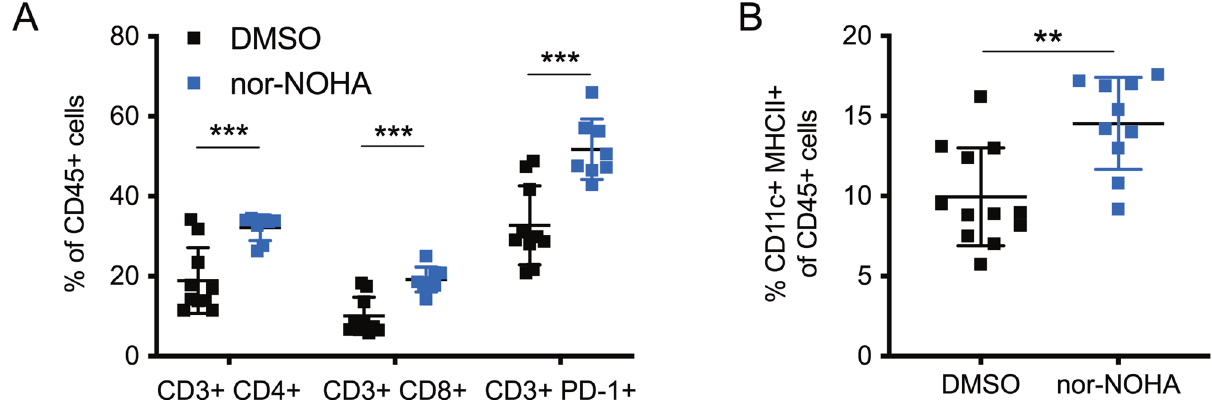
Figure 6. Transcutaneous arginase inhibition is associated with significantly more intratumoral T cells and dendritic cells in PDVC57 tumors. ( A ) Percentage of intratumoral CD45 + leukocytes that are CD3 + CD4 + , CD3 + CD8 + , or CD3 + PD-1 + indicating tumor-infiltrating T cells; CD3 + CD4 + , CD3 + CD8 + , CD3 + PD-1 + cells significantly higher in nor-NOHA-treated tumors. ( B ) Percentage of intratumoral CD45 + leukocytes that are CD11c + MHCII + , indicating tumor-infiltrating dendritic cells; significantly higher in nor-NOHA-treated tumors. ** P < 0.01; *** P < 0.001 using the unpaired t -test adjusted for multiple comparisons. Two separate experiments with n > 5 per